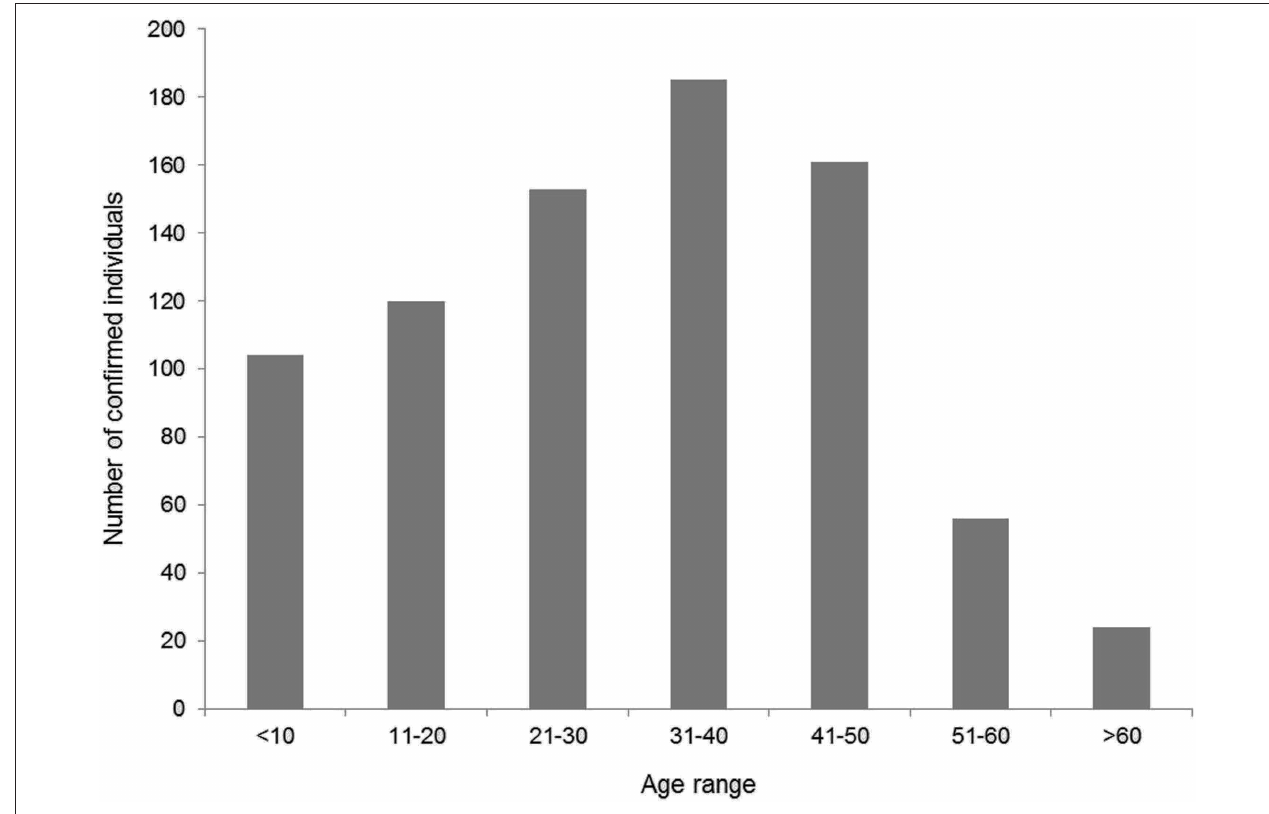
FIGURE 4 | Distribution on the basis of age of all COVID-19 confirmed cases up to 14 April